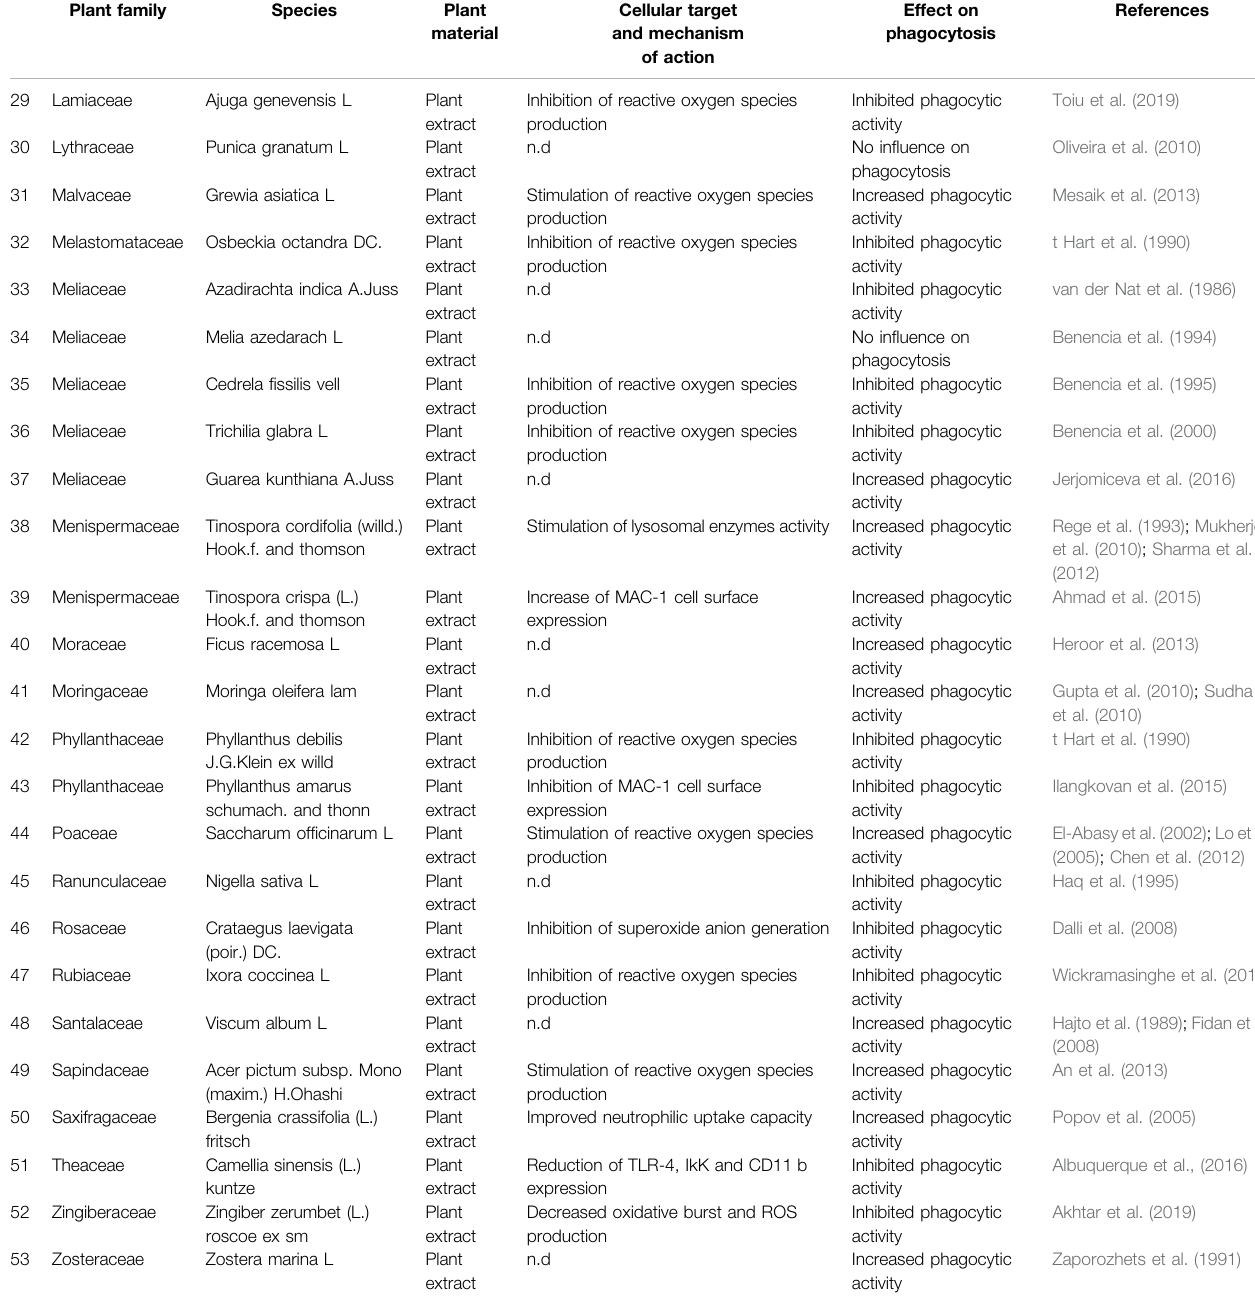
TABLE 1 | ( Continued ) List of selected plant material with documented impact on